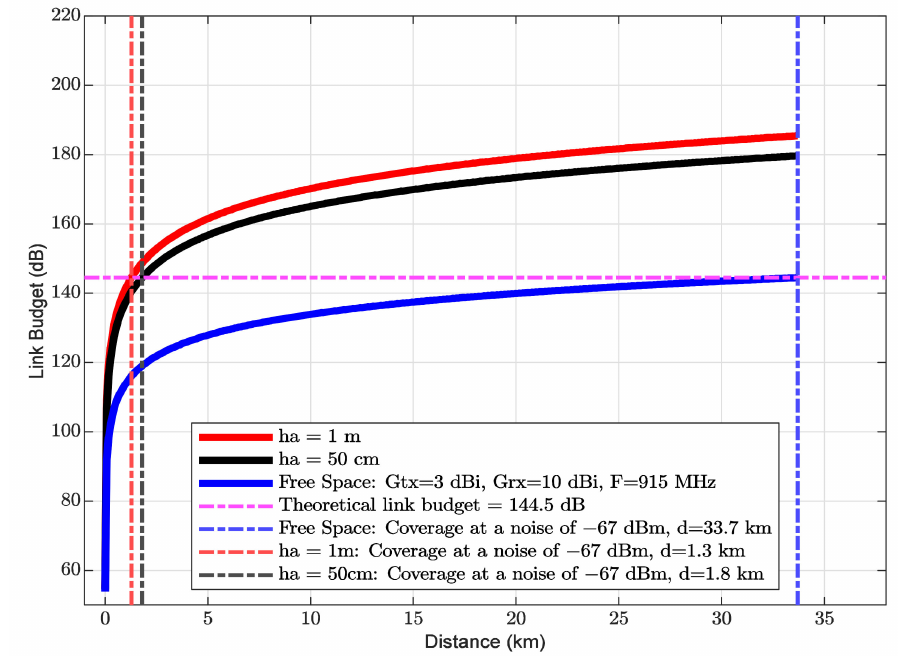
Figure 14. Link budget of the experimental path loss models at ha of 1 m and ha of 50 cm and the theoretical free space path loss model. In addition, the coverage reached by the path loss models analyzed over rivers within